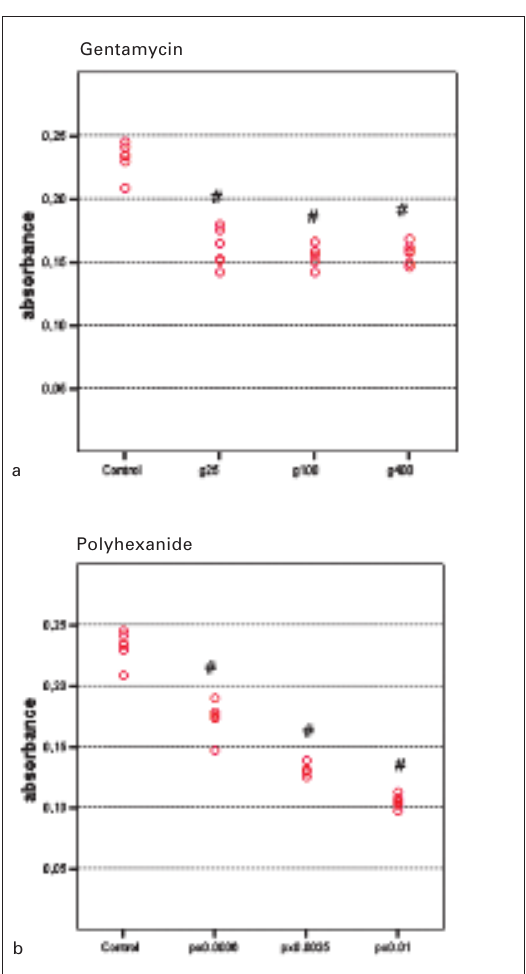
Figure 4 Effect of a) gentam- icin and b) polyhexa- nide on alkaline phosphatase activity of osteoblasts after six hour exposure (g = gentamicin, px = polyhexanide, # p <0.05 versus